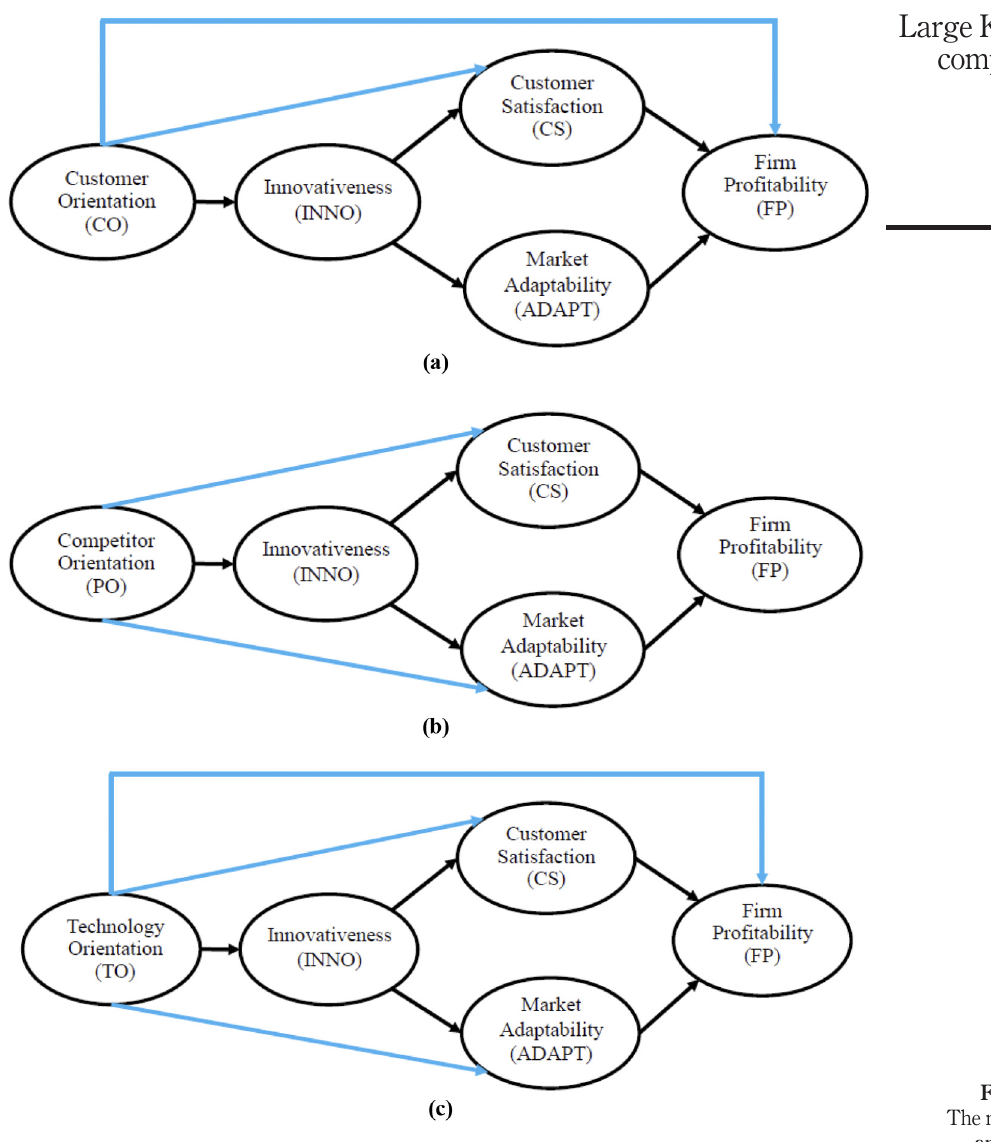
Figure 3. The mediation analyses of significant